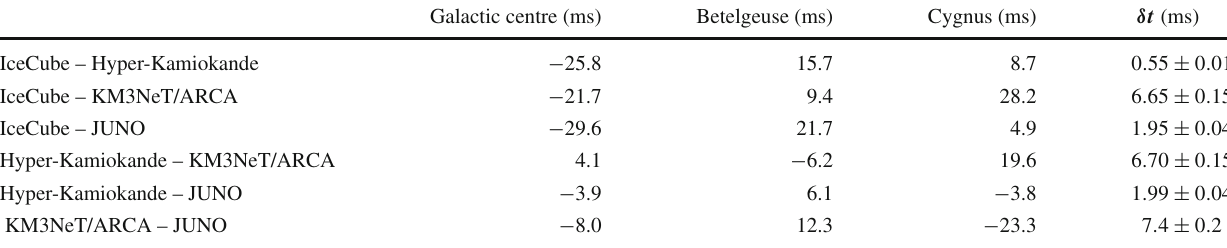
Table 6 Time delay for each detector pair, assuming the signal emission coming from the three different sources. The time delay uncertainty for each detector pair from Table 3 is given in the last